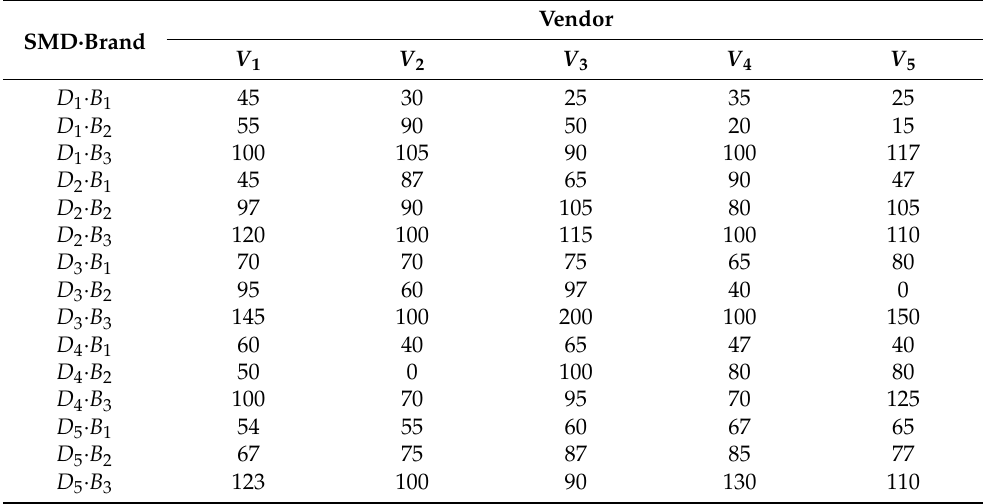
Table 11. The upper bound for the number of SMD types.